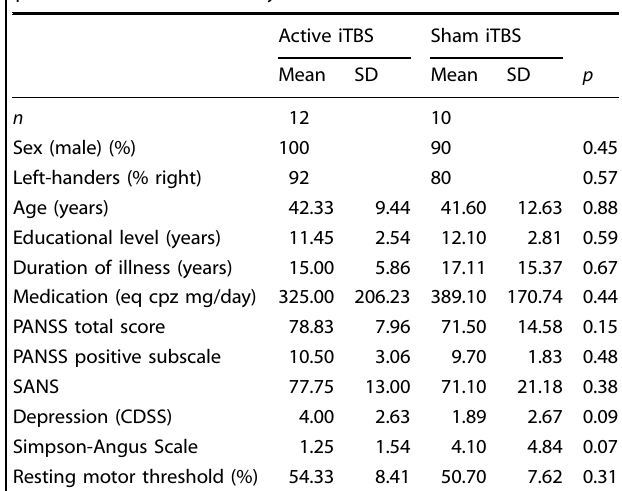
Table 1. Demographic and clinical baseline characteristics of the patients included in the study.